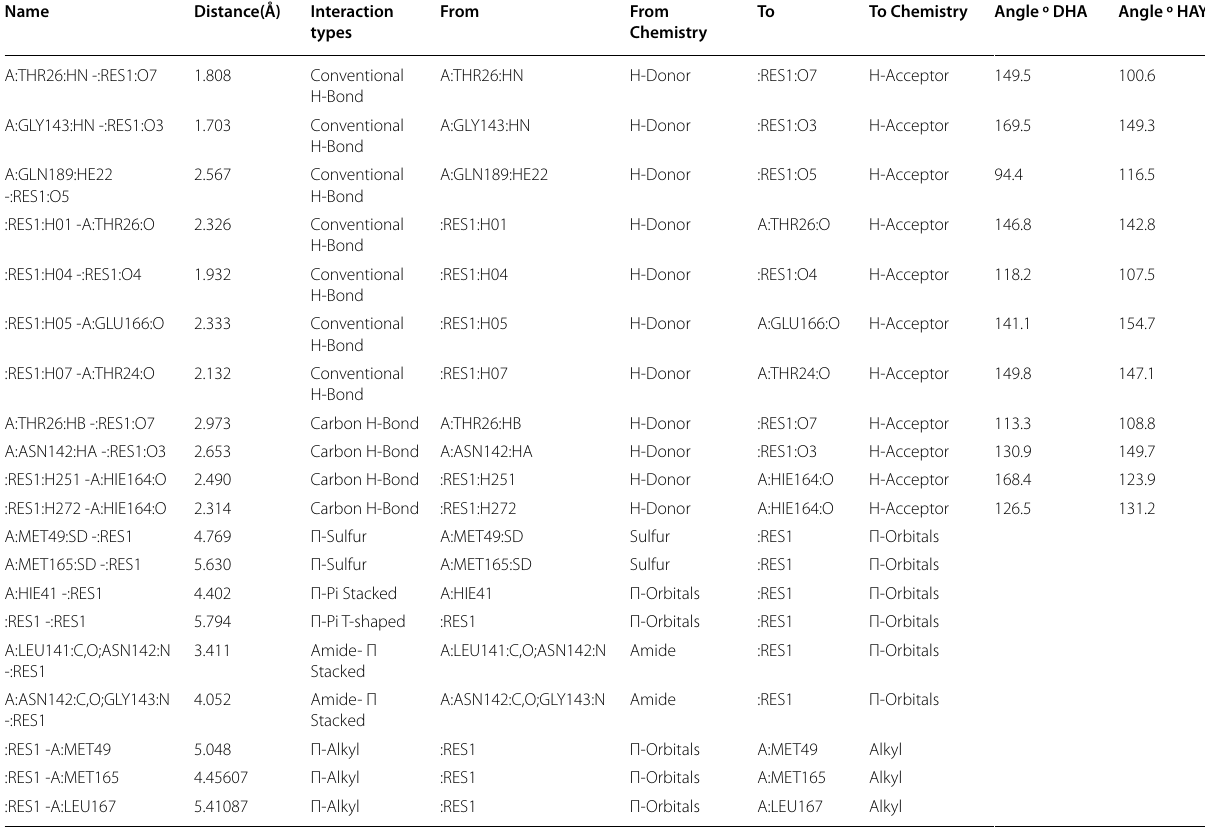
Table 10 Interaction types of surrounding amino acids of SARS CoV 2 Main Protease (PDB ID: 6xbh) with inhibitor with Index number 741a